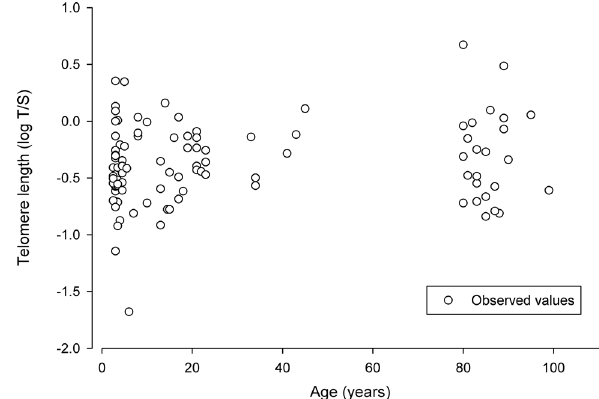
Figure 4. The relationship between age and relative telomere length measured from red blood cells (expressed as the natural log of the T/S ratio) of bigmouth buffalo ( Ictiobus cyprinellus ). There was no significant relationship between age and telomere length (F 1,95 = 0.65, p = 0.42, r 2 =